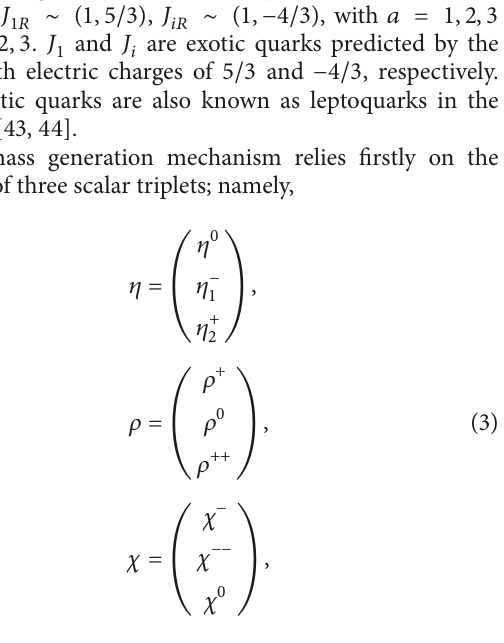
neutrinoless double beta decay if it mixes with the 𝑊